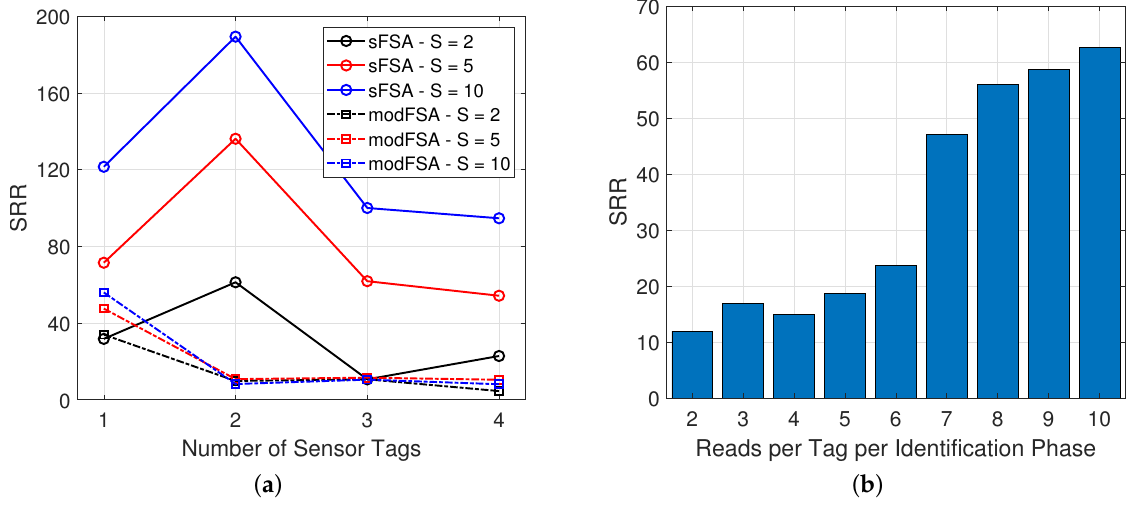
Figure 11. Results of the comparison between the modified FSA (modFSA) and the sFSA protocol with varying tags and reads per tag. ( a ) Comparison of SRR between the modFSA and sFSA with N = 1, 2, 3, 4 tags and S = 2, 5, 10 reads per tag. ( b ) Variation of the number of reads per tag in the Sense phase with N =